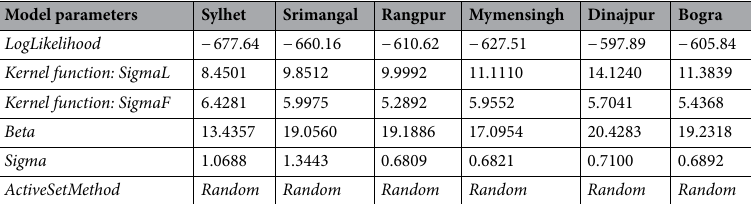
Table 5. Optimized parameters of EGPR models in one year lead